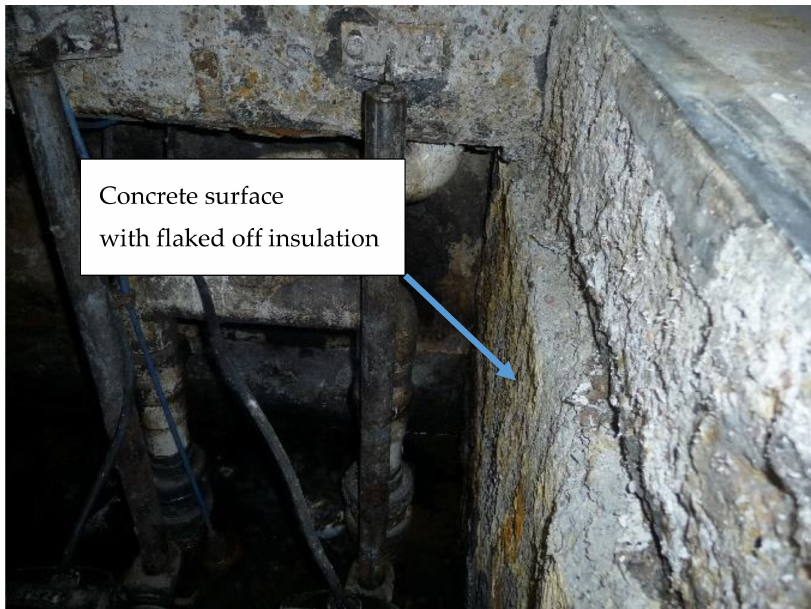
Figure 3. Walls below the ceiling slab were originally covered with insulation but in a considerable area of the walls this insulation had already flaked o ff